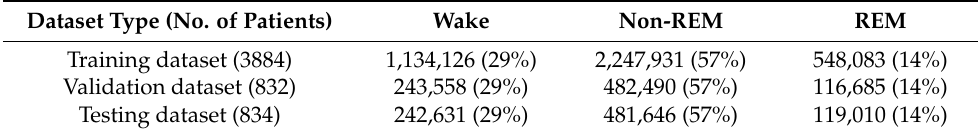
Table 8. Summary of the SHHS dataset.